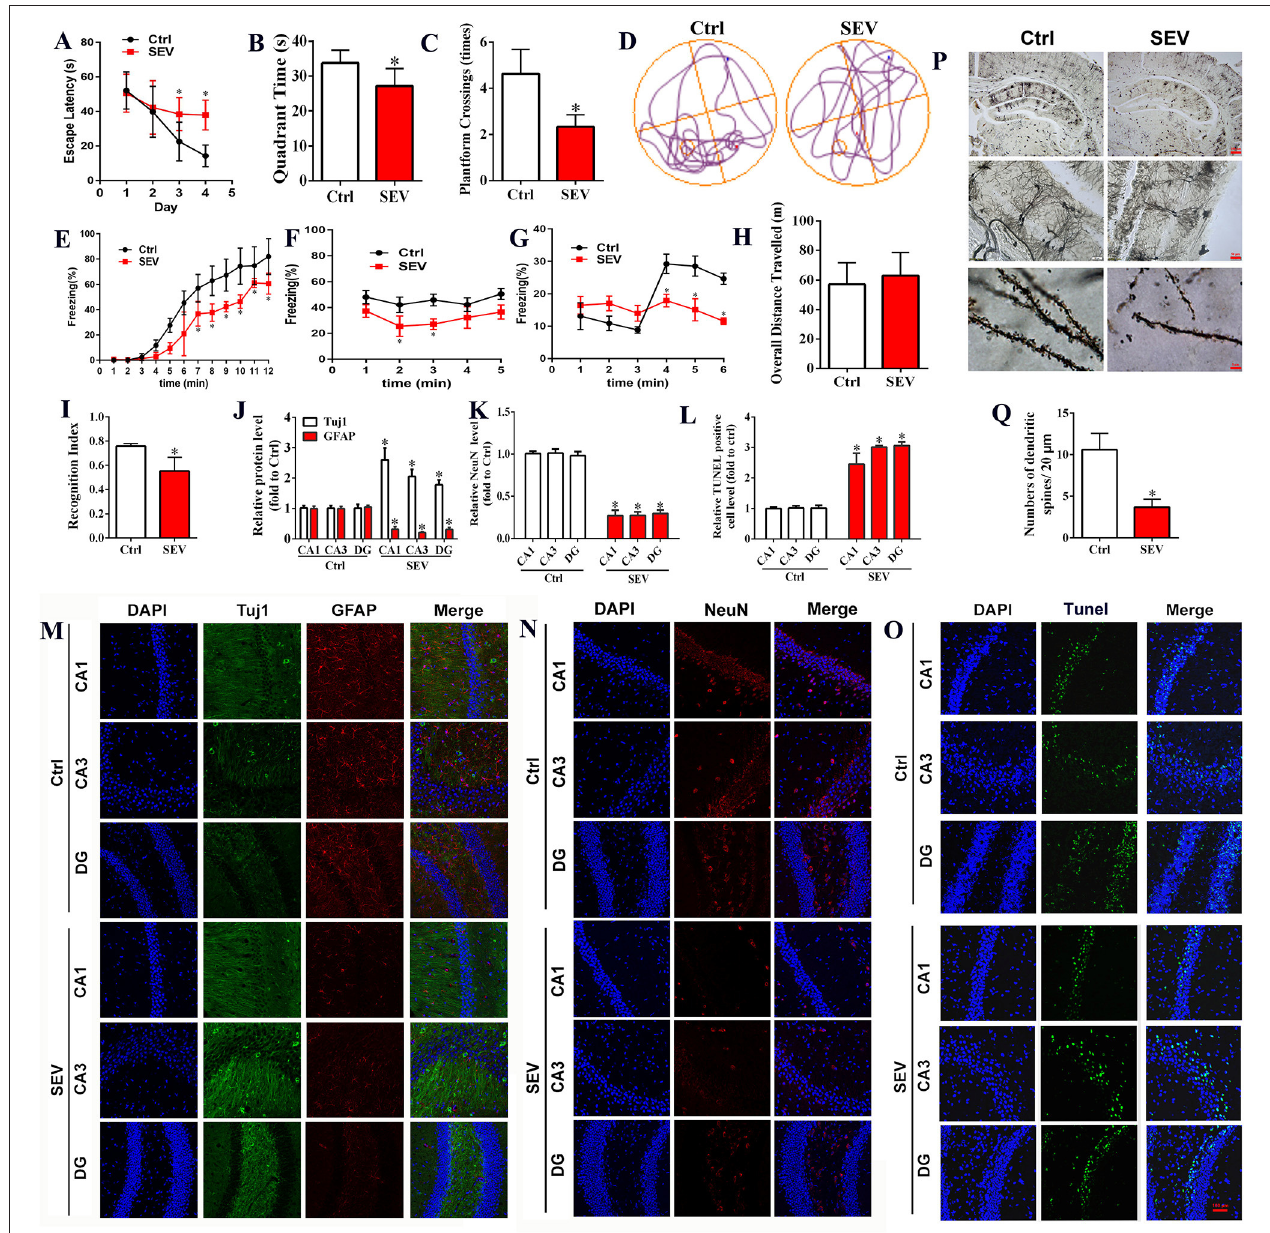
FIGURE 1 | Sevoflurane exposures induced cognitive impairment in neonatal mice associated with neuronal death and abnormal synapse formation. (A–D) Morris water maze tests including the time course of escape latency, the time spent in the target quadrant, platform crossing number, and moving track [ (A) : two-way ANOVA, Bonferroni’s multiple comparisons test, interaction: F (3,60) = 7.34, mean difference (95% CI): − 15.14 ( − 26.38 to − 3.897) (Day 3 Ctrl vs. SEV) and − 23.99 ( − 35.23 to − 12.75) (Day 4 Ctrl vs. SEV), p < 0.001; (B) : t- test, p = 0.0097; (C) : t- test, p < 0.001; n = 8]; (E–G) freezing behavior detected by fear condition test, including the percentage of freezing when mice received training [ (E) : two-way ANOVA, Bonferroni’s multiple comparisons test, interaction: F (11,60) = 2.590, mean difference (95% CI): 16.25 ( − 0.04037 to 32.54)(7min), 20.93 (4.643 to 37.22) (8min), 19.58 (3.288 to 35.87) (9min), 22.54 (6.248 to 38.83) (10min), 7.632 ( − 8.657 to 23.92) (11min), 17.42 (1.133 to 33.71) (12min), p < 0.01], without sound stimulus and foot shock [ (F) two-way ANOVA, Bonferroni’s multiple comparisons test, interaction: F (4,25) = 0.1686, mean difference (95% CI): 15.27 ( − 15.13 to 45.67) (2min) and 18.47 ( − 11.92 to 48.87) (3min), p < 0.05], and with only sound stimulus [ (G) two-way ANOVA, Bonferroni’s multiple comparisons test, interaction: F (5,30) = 3.463, mean difference (95% CI): 9.258 ( − 4.760 to 23.28) (4min), 13.21 ( − 0.8051 to 27.23) (5min), and 12.32 ( − 1.697 to 26.34) (6min), p < 0.05; n = 6 ) ; (H,I) novel object recognition comprising of the overall distance of traveling and the recognition index [ (H) : t- test, p > 0.05; (I) : t- test, p < 0.001; n = 8); (J,K,M,N) immunofluorescent staining for Tuj1, GFAP, and NeuN in hippocampus [ (J,K) : t- test, p < 0.05); (L,O) cell apoptosis detection by TUNEL staining ( t- test, p < 0.05); (P,Q) Golgi-Cox staining for analyzing synapse formation ( t- test, p < 0.001). Scar bar = 100 µ m, applied in (M–O) . * p < 0.05, Ctrl vs. SEV.